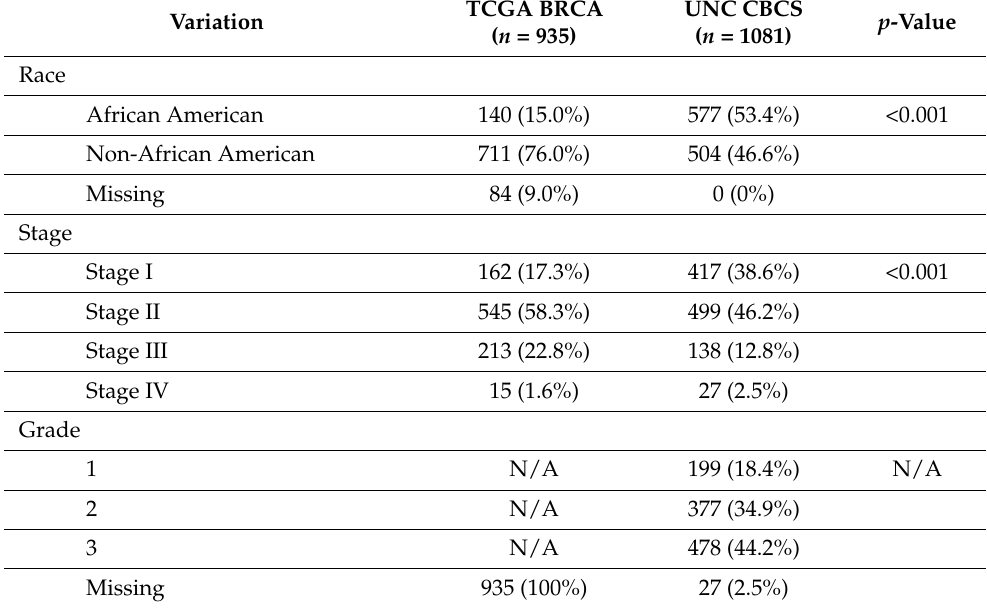
Table 1. Comparison of clinical features for TCGA BRCA and UNC